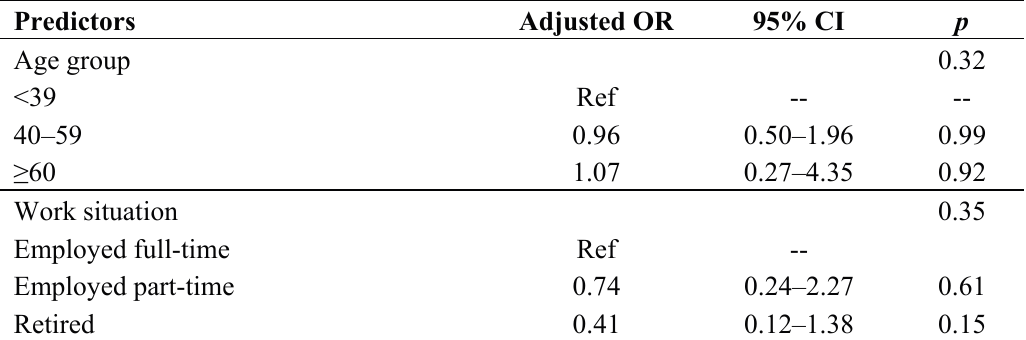
Table 3. Multiple logistic regression model indicating correlates of exposure to SHS in the home in the last 7